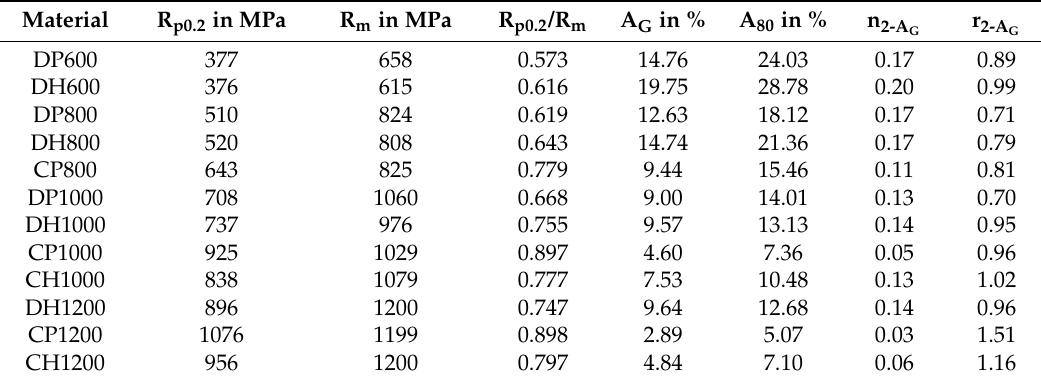
Table A3. Mechanical properties longitudinal (to rolling) direction (LD).